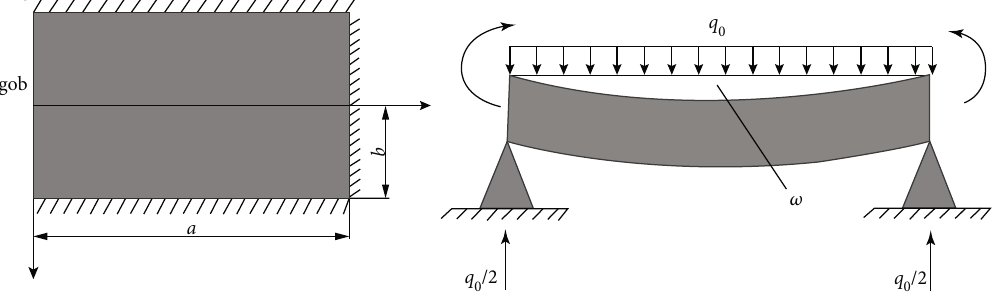
Figure 5: Mechanical model of bed separation zone periodic development under uniform load.